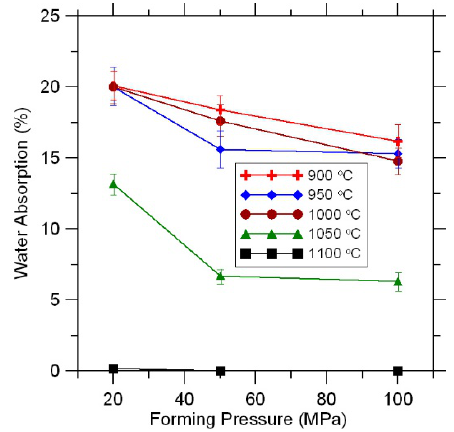
Figure 7. Fire shrinkage versus forming pressure at different firing temperatures.